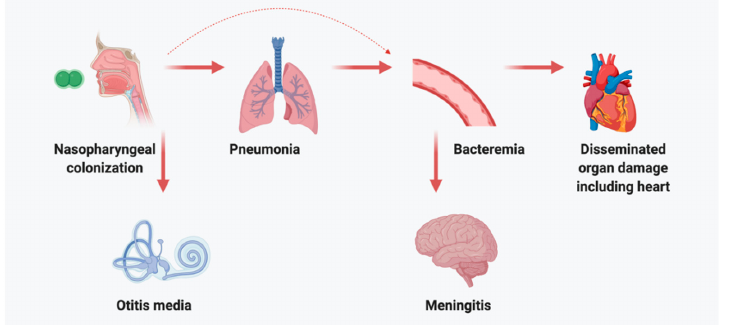
Figure 1. Pneumococcal pathogenesis. Streptococcus pneumoniae ( Spn ) pathogenesis begins with successful colonization of the nasopharynx, where it typically resides asymptomatically. Given the opportunity, particularly in those who have recently experienced viral infection or are immuno- compromised, Spn can cause localized disease in the middle ear (otitis media) and in the lungs (pneumonia). Failure to control these infections, allows Spn to escape into the bloodstream (bacte- remia) and cause sepsis, systemic disseminated organ damage, which includes the heart, and cen- tral nervous system.